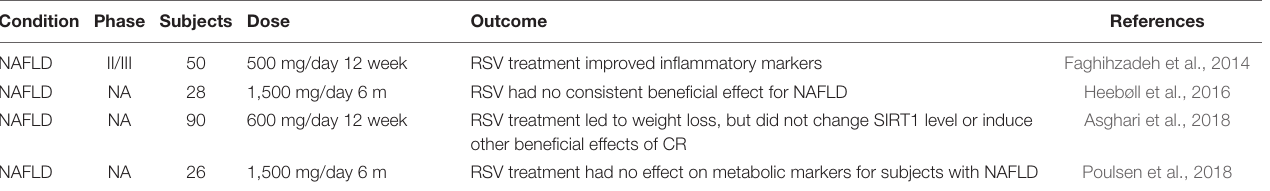
TABLE 8 | Clinical trials of resveratrol for